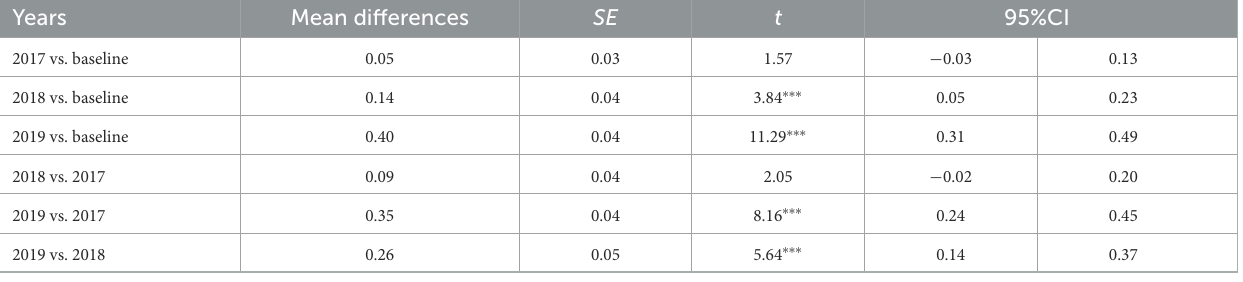
TABLE 4 Multiple comparisons: mean differences and confidence intervals for 50m sprint across mean baseline (2013–2016), 2017, 2018, and 2019.